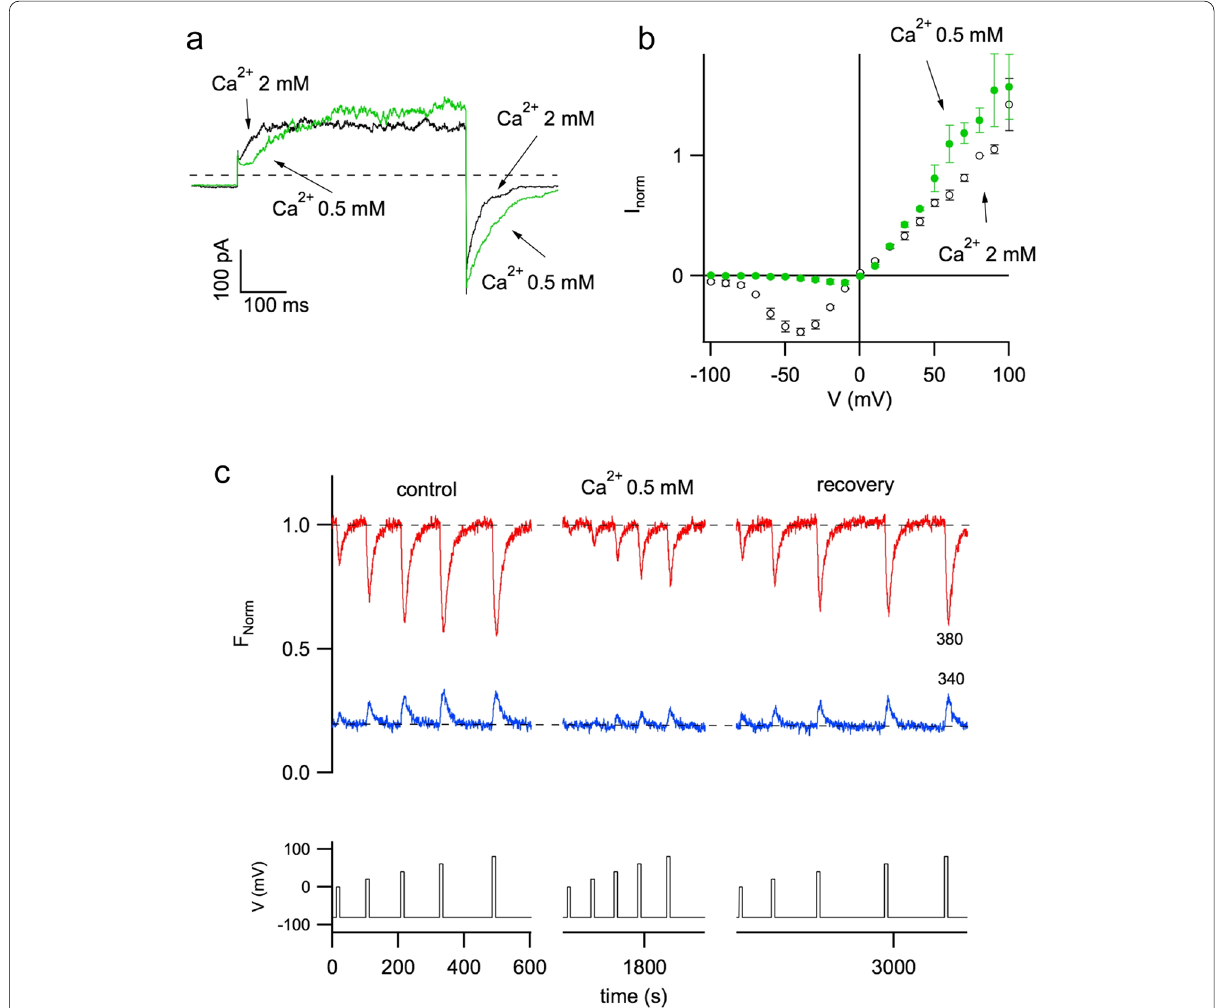
Fig. 3 Plant TPC channels are modulated by cytosolic calcium. a Current recordings of carrot TPC channels in the presence of 2 mM (black trace) and 0.5 mM (green trace) cytosolic calcium. Main voltage pulse of 80 mV; holding voltage was 80 mV. b Stationary currents in 2 mM (black open + − circles) and 0.5 mM (green solid circles) cytosolic calcium were normalized to the value at 80 mV in 2 mM Ca 2 + and displayed versus voltage. + Voltage pulses were ranging from 100 mV to 100 mV in 10 mV increments. c Patch pipette was filled with 100 μM of the calcium-sensitive dye − + fura-2. Fluorescence signals (upper panel) were induced by excitation light at 380 nm (red trace) and 340 nm (blue trace), respectively. The lower panel displayed 10 s voltage pulses of 0, 20, 40, 60, 80 mV, which were applied starting in 2 mM Ca 2 + (control, left panel), at low calcium + + + + (Ca 2 + 0.5 mM, middle panel), and again in 2 mM Ca 2 + (recovery, left panel). Modification of Figs. 1 and 2, from Carpaneto and Gradogna (2018), Biophysical Chemistry, 236:1–7, reprinted by permission from Elsevier (license number